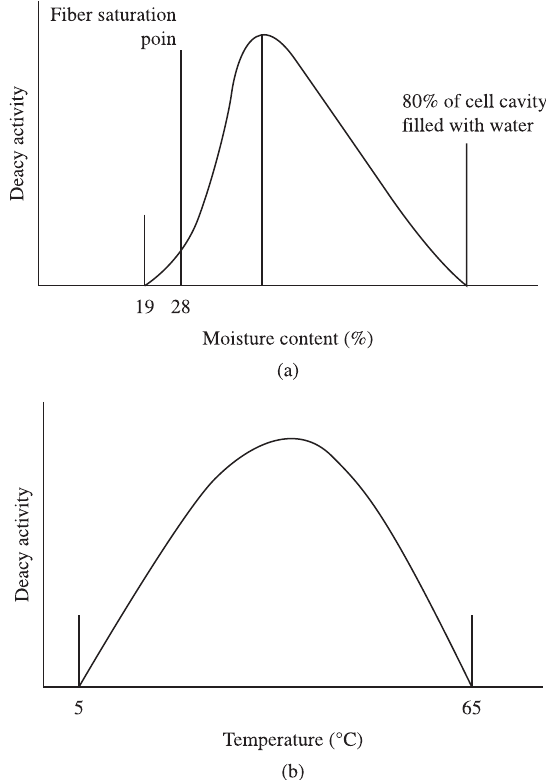
Figure 1. Functions idealized for two parameters of decay 8 .